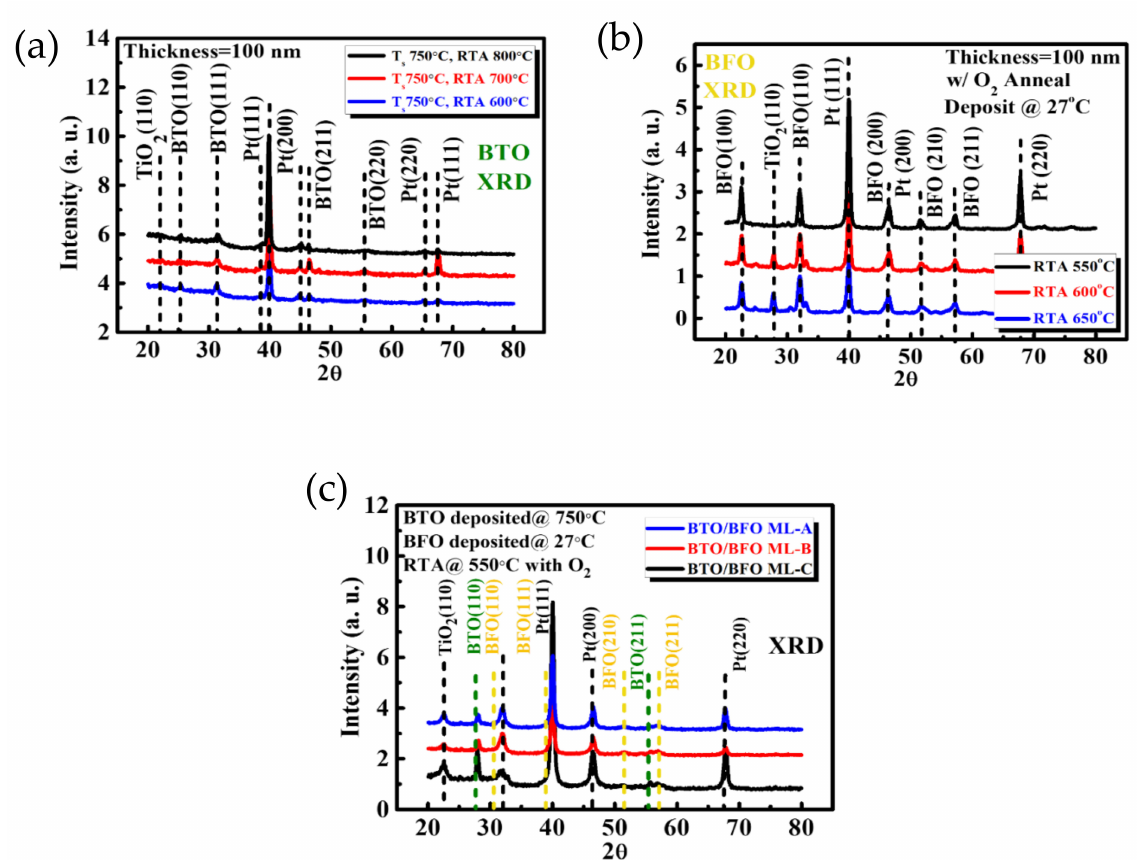
Figure 2. The X-ray Diffraction (XRD) patterns of the ( a ) single BaTiO 3 (BTO) thin film, ( b ) single BiFeO 3 (BFO) thin film with different post annealing conditions, and ( c ) multi-layer BFO/BTO structures from Condition A (ML-A) to Condition C (ML-C). RTA, Rapid Thermal Annealing.